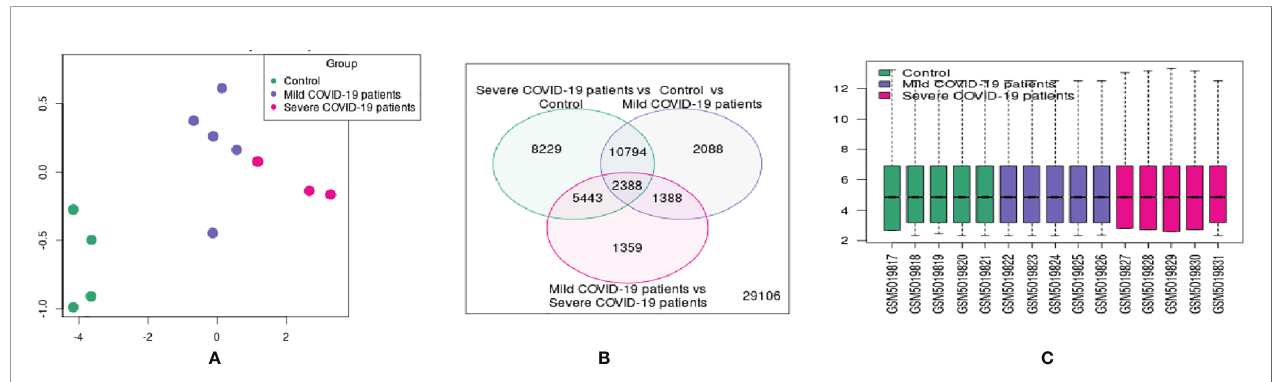
FIGURE 3 | Visualization of identi fi ed DEGs using MD . (A) DEGMD plot using the data of control vs. mild COVID-19 patients. (B) DEGMD plot using the data of severe COVID-19 patients vs. control healthy volunteers. (C) DEGMD plot using the data of mild COVID-19 patients vs. severe COVID-19 patients. In this fi gure, red dots denote upregulated DEGs, and blue dots denote downregulated DEGs.